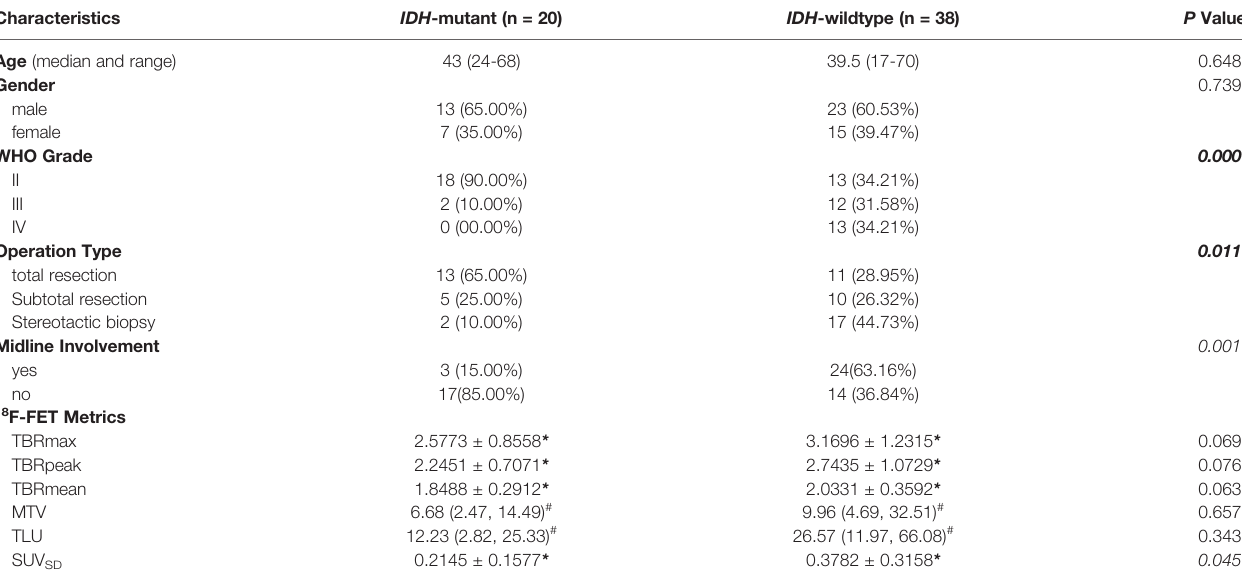
TABLE 1 | Clinical features and 18 F-FET PET semi-quantitative parameters based on IDH genotype.